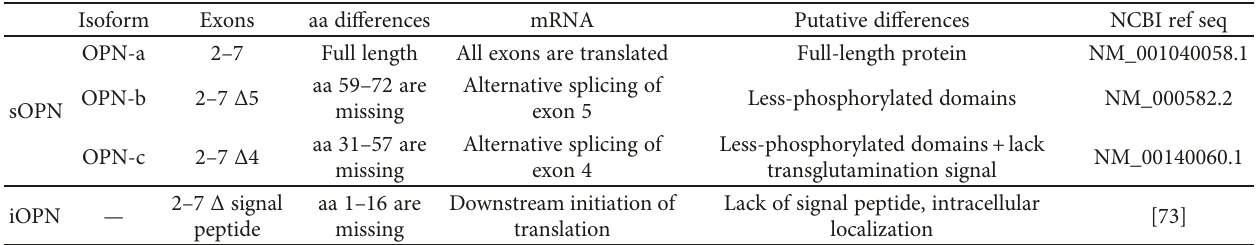
Table 1: Summary of several features of the main OPN